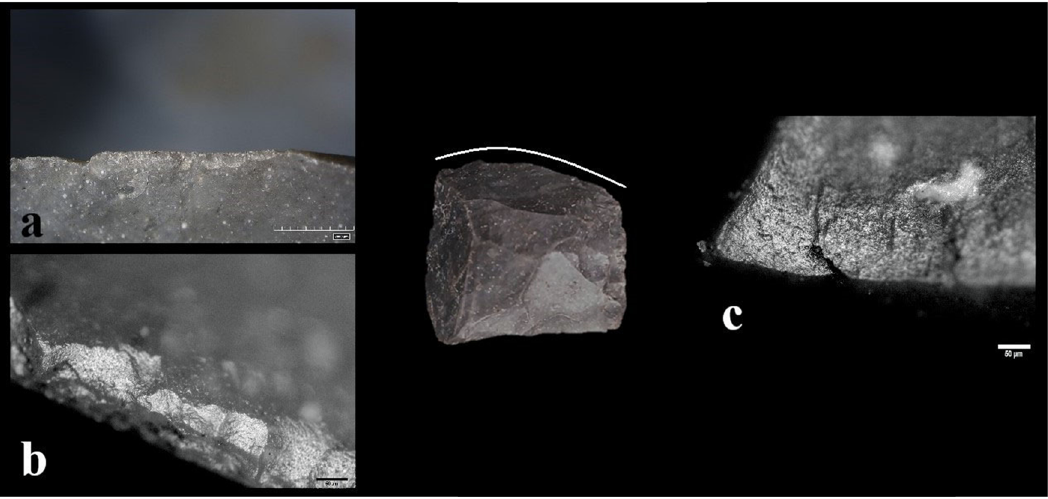
Figure 9: ( a ) Edge rounding and step, regular continuous scars, ( b ) polish that penetrated the scars, and ( c ) mixture of diverse materials, fl at topography scaling ( photo A. Petrovi ć )